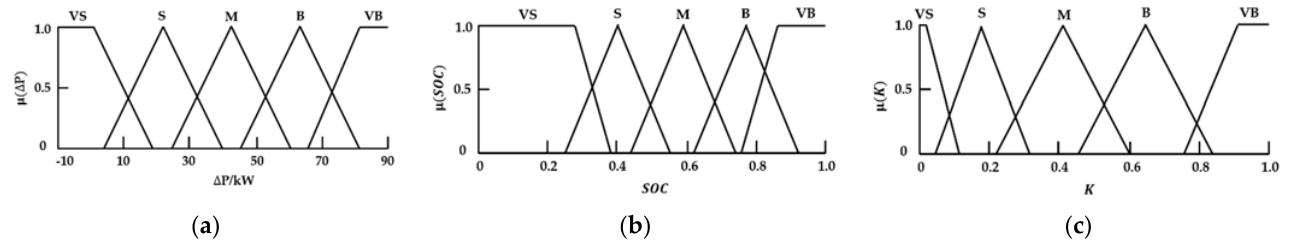
Figure 6. Flow chart of the composite fuzzy energy management strategy. ( a ) Membership function of input power; ( b ) Membership function of SOC; ( c ) Membership function of proportional coefficient of fuel cell output power.